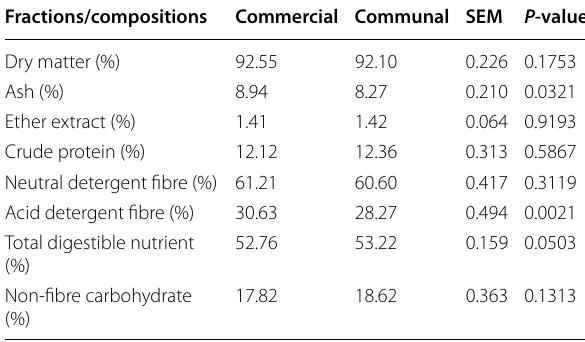
Table 1 Proximate composition of pastures from grazing